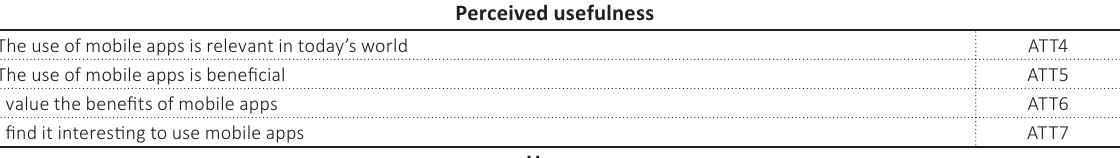
Table A1 (cont.). Examining antecedents affecting Indian consumers’ adoption of mobile